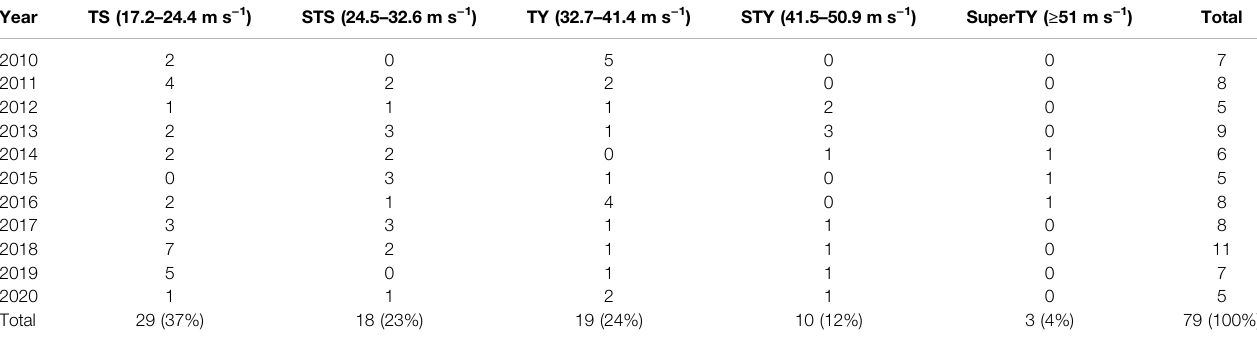
TABLE 1 | Samples of TCs at different intensity levels by the time of landfall in mainland China from 2010 to 2020. Year TS (17.2 – 24.4 m s − 1 )